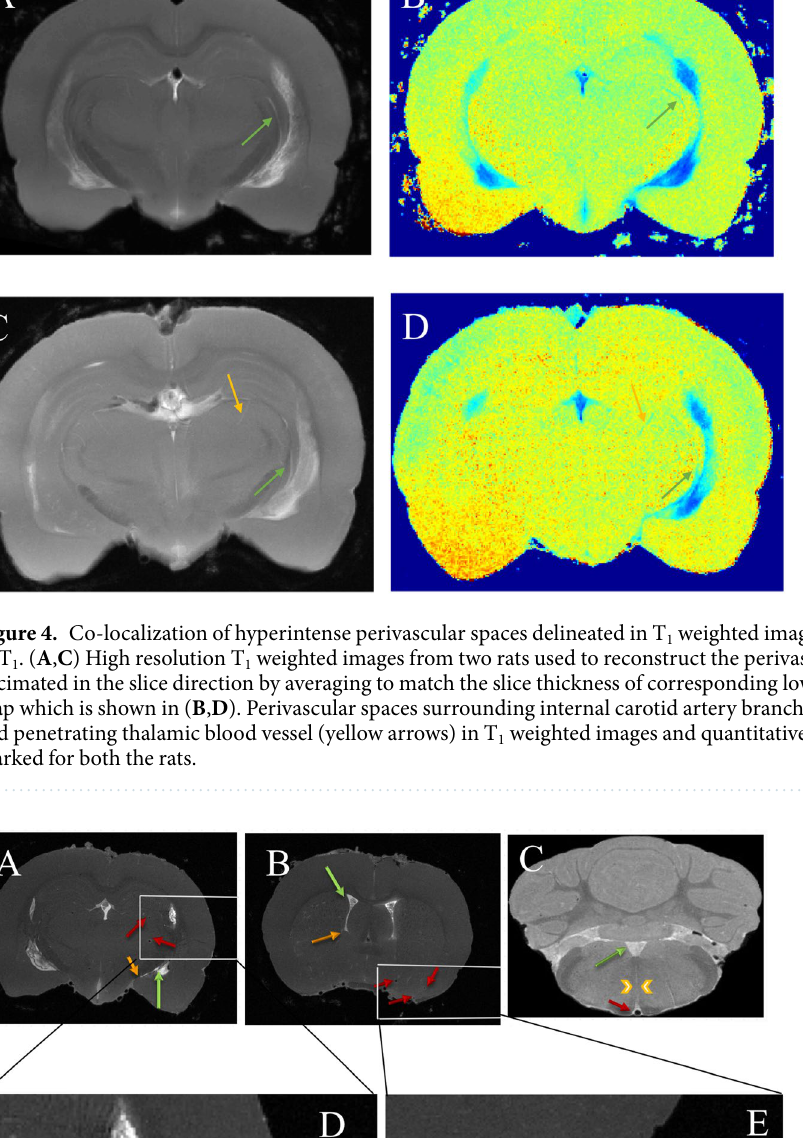
outside the vessel lumen in the PVS could be confirmed in future studies through electron microscopy involving electron dense tracers such as colloidal gold 19 .